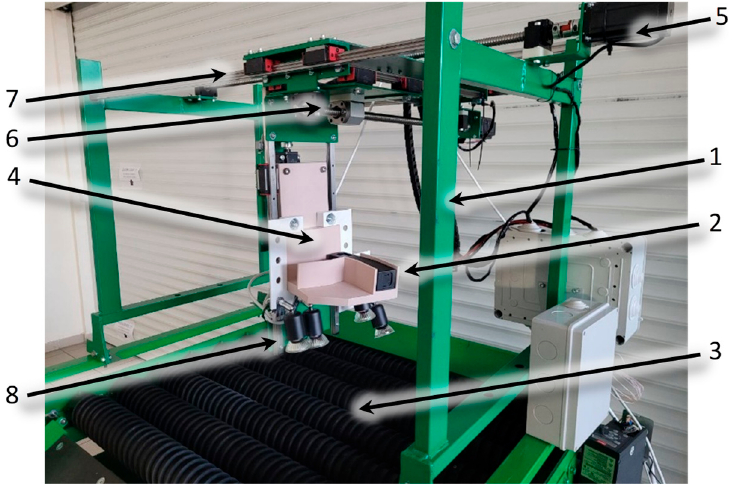
Figure 1. The setup for the hyperspectral imaging of apple fruits. Designations: chassis (1); the hyperspectral camera (2), a table with rubber rollers (3) camera suspension (4), stepper motors (5, 6) and the transmission (7), light source (8).